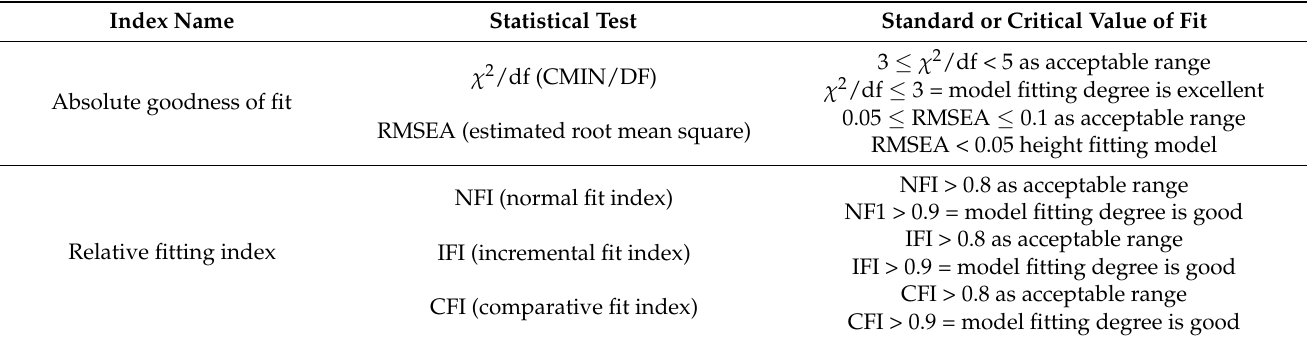
Table 5. Fit index evaluation standards [35].